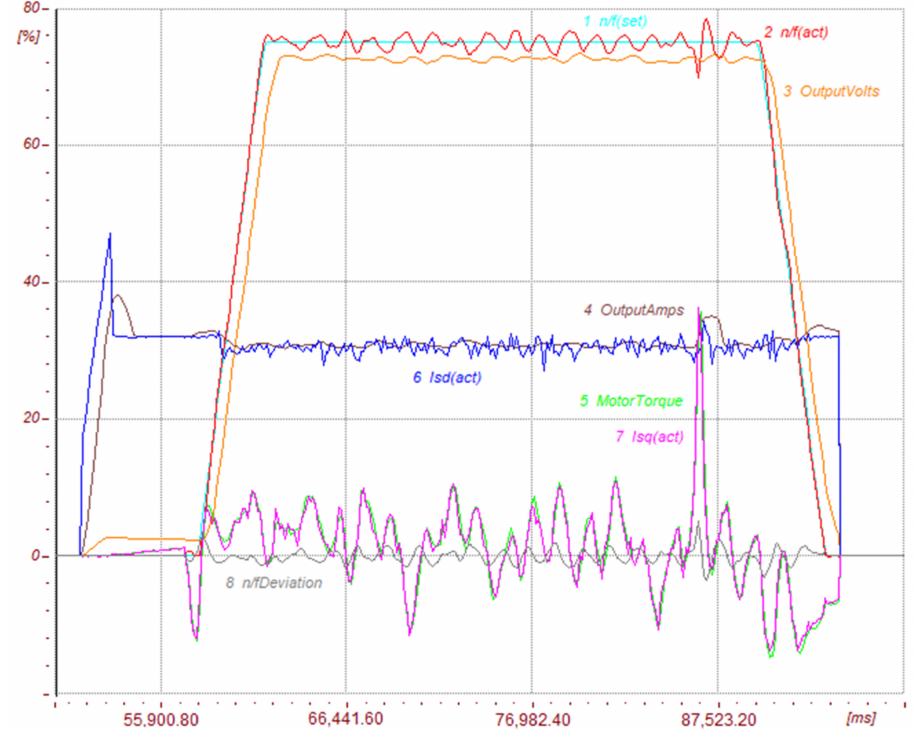
Figure 12. Starting curves of the mining stacker with torque correction after 10 years of service.